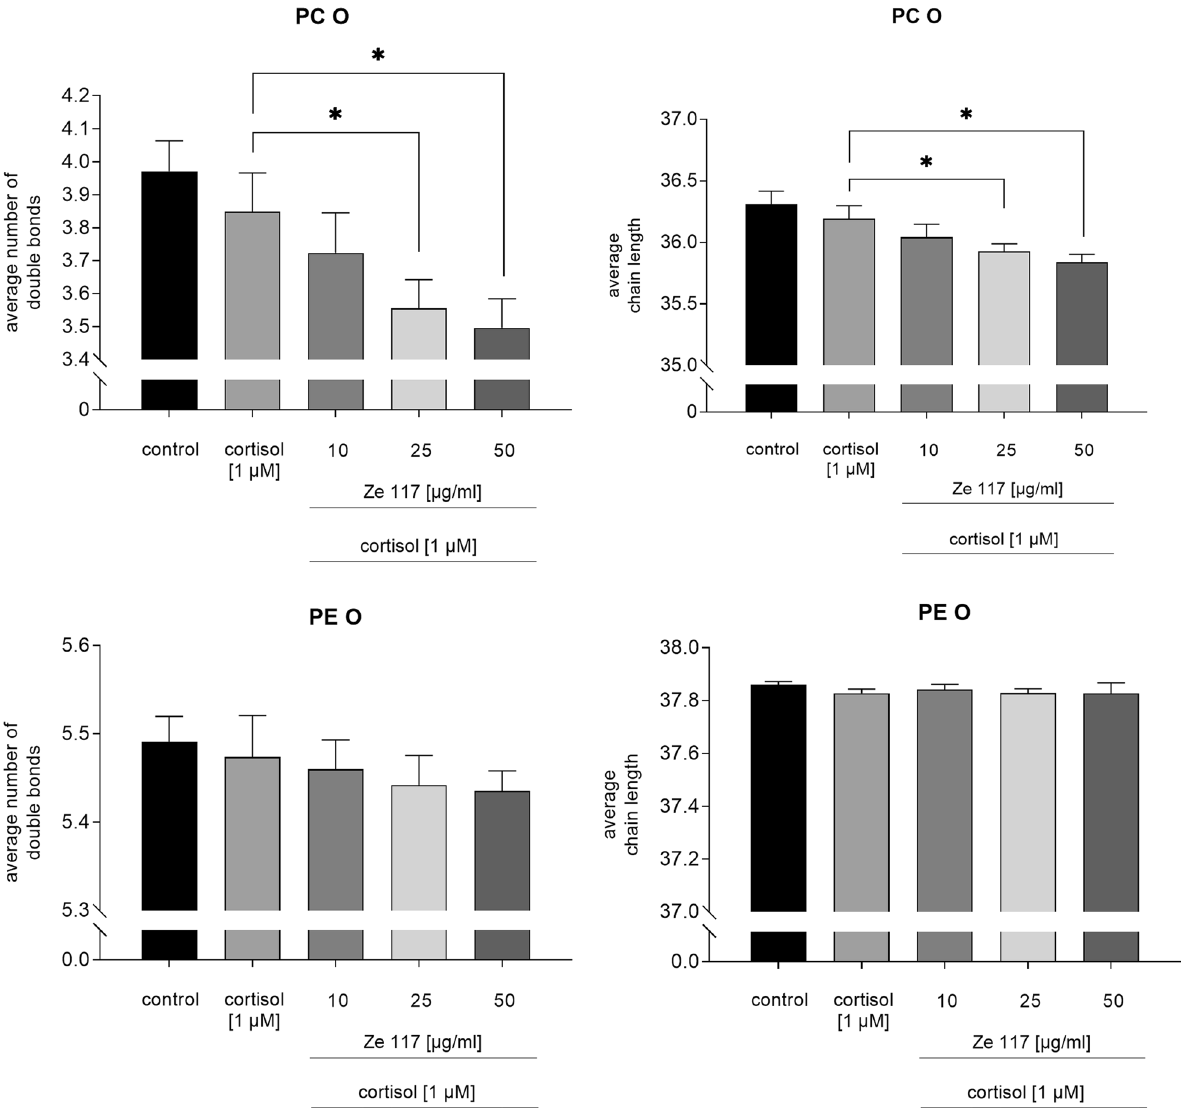
Fig. 5 Average chain length and average number of double bonds of phosphatidylcholine ethers (PC O) and the phosphatidylethanolamine ethers (PE O) species after cortisol and cortisol/Ze 117 preincubation, respectively. For statistical evaluation the cortisol condition was compared to the control. Average chain length and average number of double bonds of cortisol/Ze 117 pre-treated cells was compared against the cortisol condition. *Marked values are significantly different from corresponding control with p < 0.05 (**p < 0.01, ***p < 0.001, ****p < 0.0001) determined by one-way ANOVA (n 4), followed by Holm-Šídák =